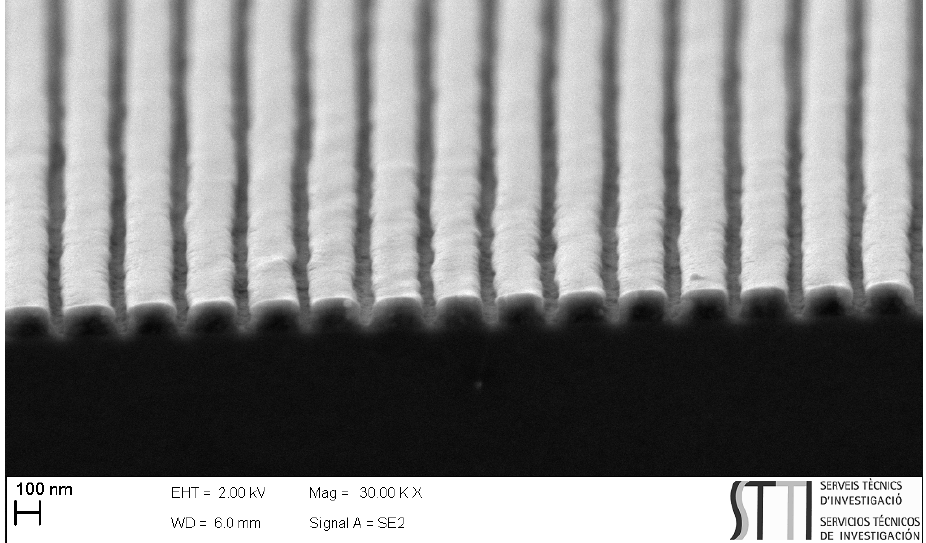
Figure 3. FESEM image of a dry developed DCG grating with Λ = 250 nm.